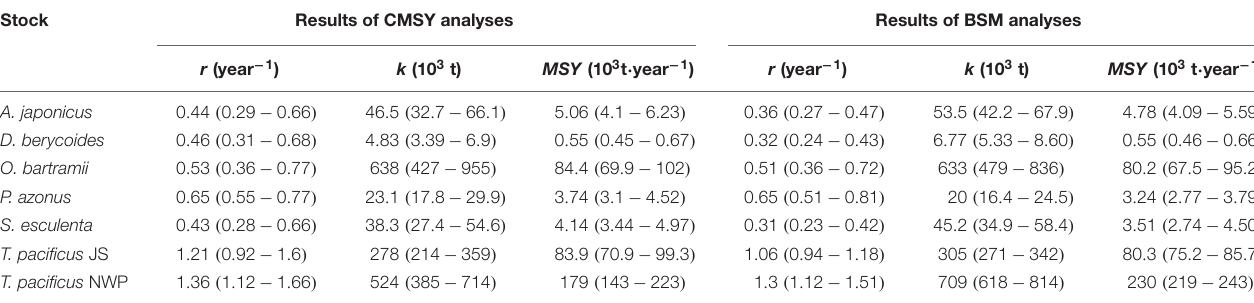
TABLE 6 | Results of CMSY and BSM analyses of 7 stocks with catch time series and CPUE available (confidence limits in brackets). Stock Results of CMSY analyses Results of BSM